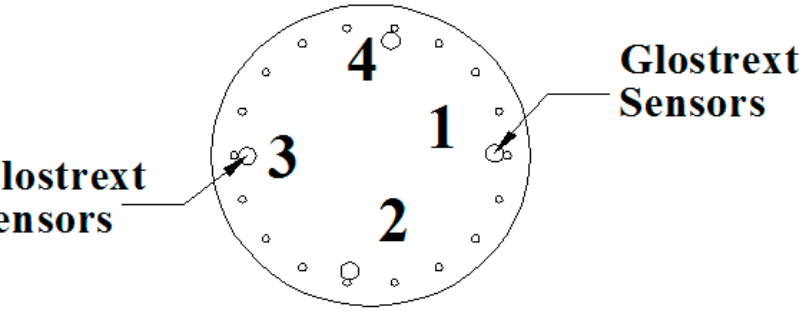
Figure 4. Cross-section of BP# 1 (D = 1,800 mm) and BP# 2 (D = 1,000 mm).